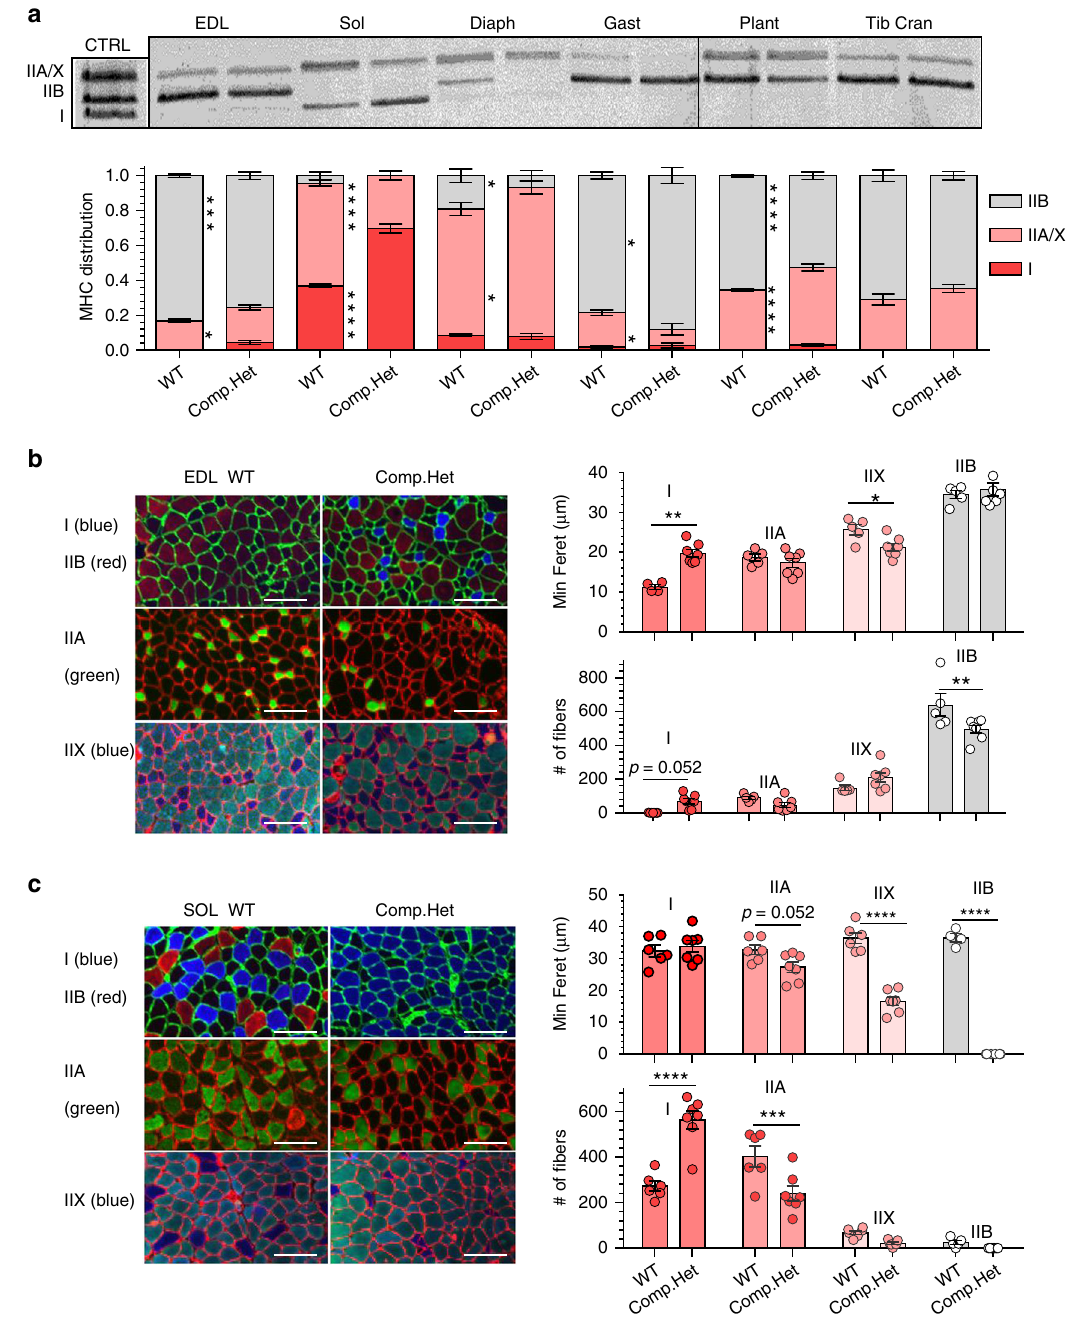
Fig. 4 Myosin heavy chain (MHC) isoform distribution and CSA analysis. a MHC expression in Compound-Het animals display signi fi cant changes in MHC distribution. A shift away from type IIB and toward slower myosin isoforms (either type IIA/X or type I) is observed in most muscle types (an exception is the tibialis m.). Top representative MHC gel images; bottom analyzed results. The control (CTRL) is a pooled homogenate of TC and Soleus muscle, revealing the 3 isoforms that can be discerned: type I, IIA/X and IIB (from bottom to top). b Example cross-sections stained with antibodies that are MHC-type speci fi c (left), minFeret diameter (right, top) and number of fi bers (right, bottom) in EDL muscle. MinFeret is increased in type I fi bers and reduced in IIX. The number of type I fi bers number is increased (only 3 type I fi bers were found in WT mice) and the number of type IIB fi bers is reduced. Scale bar: 100 μ m. c Example cross-sections stained with antibodies that are MHC-type speci fi c (left), minFeret diameter (right, top) and number of fi bers (right, bottom) in soleus muscle. There is a reduction in type IIX and IIB minFeret and an increase in the number of type I and a reduced number of